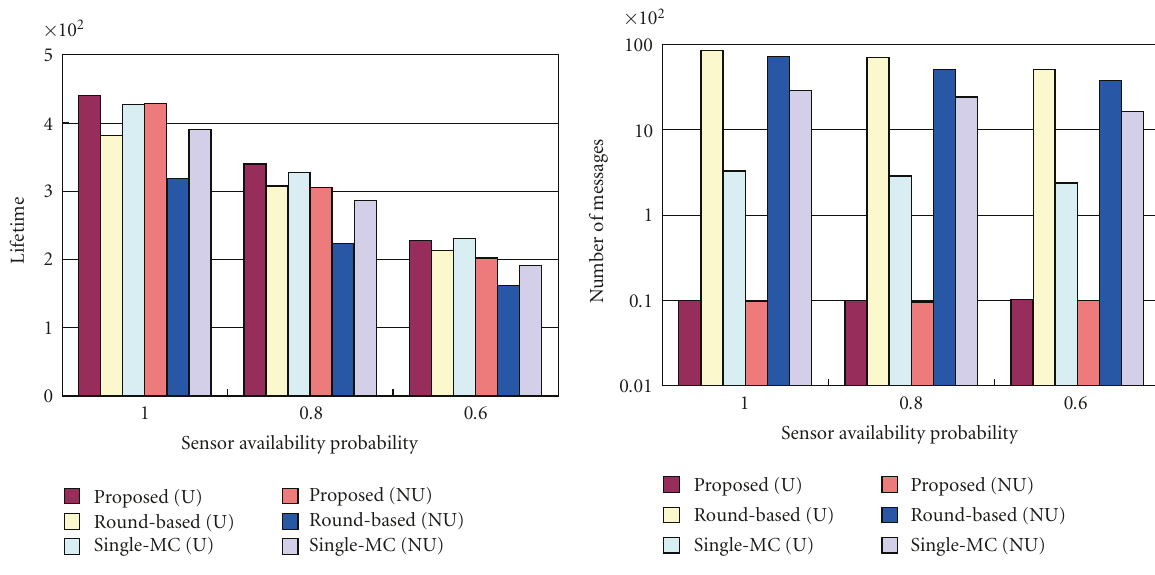
Figure 16: Varying sensor availability probability